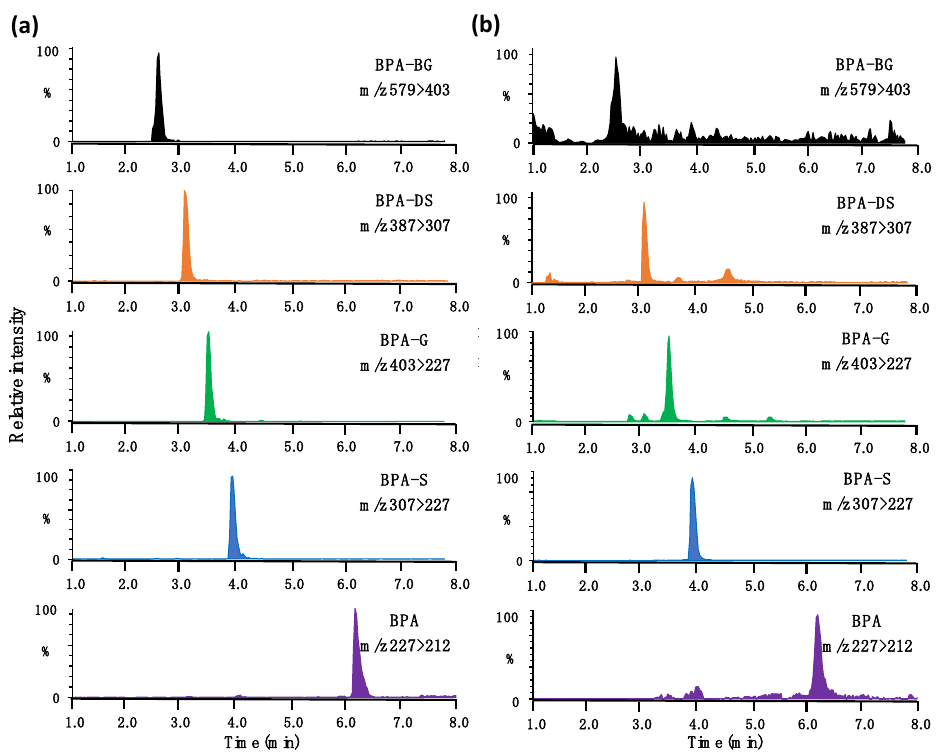
Figure 1. Representative chromatograms of BPA and its conjugated metabolites in ( a ) the 50% methanol/water solution and ( b ) rat blood.